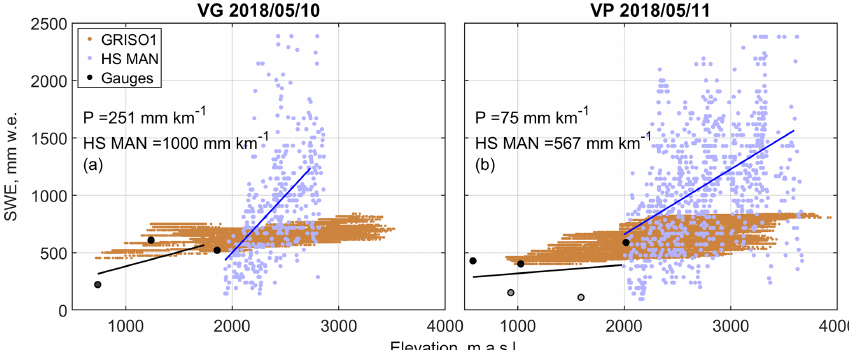
Figure 4. Winter orographic gradients estimated by precipitation gauges (black dots and line) vs. those estimated by snow courses (blue dots and line; HS MAN – snow courses manual measurements) in 2018. The grayscale for precipitation gauge data points measures the amount of gaps in the time series, with black meaning a complete time series and white a time series with nearly 100% missing data points. The brown cloud is the winter orographic gradient estimated by GRISO1, which only relied on precipitation gauges. VG and VP are Beauregard and Valpelline, respectively. Similar plots for other water years are reported in Figs. S15 to